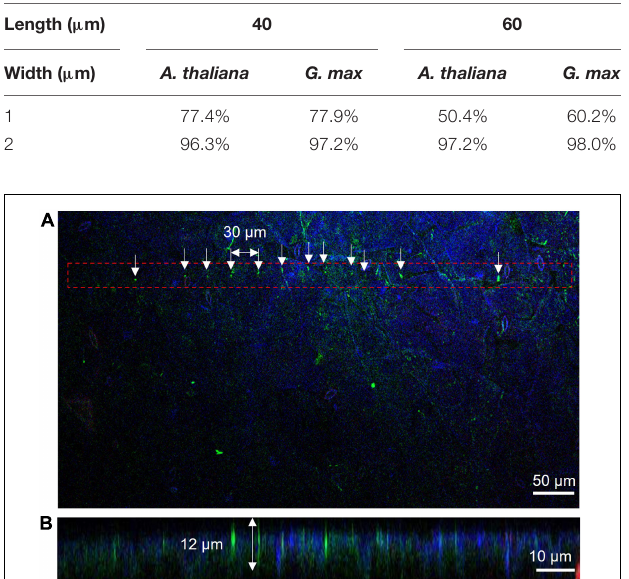
TABLE 1 | Insertion efficiency results on Arabidopsis thaliana leaf tissue and Glycine max SAM.